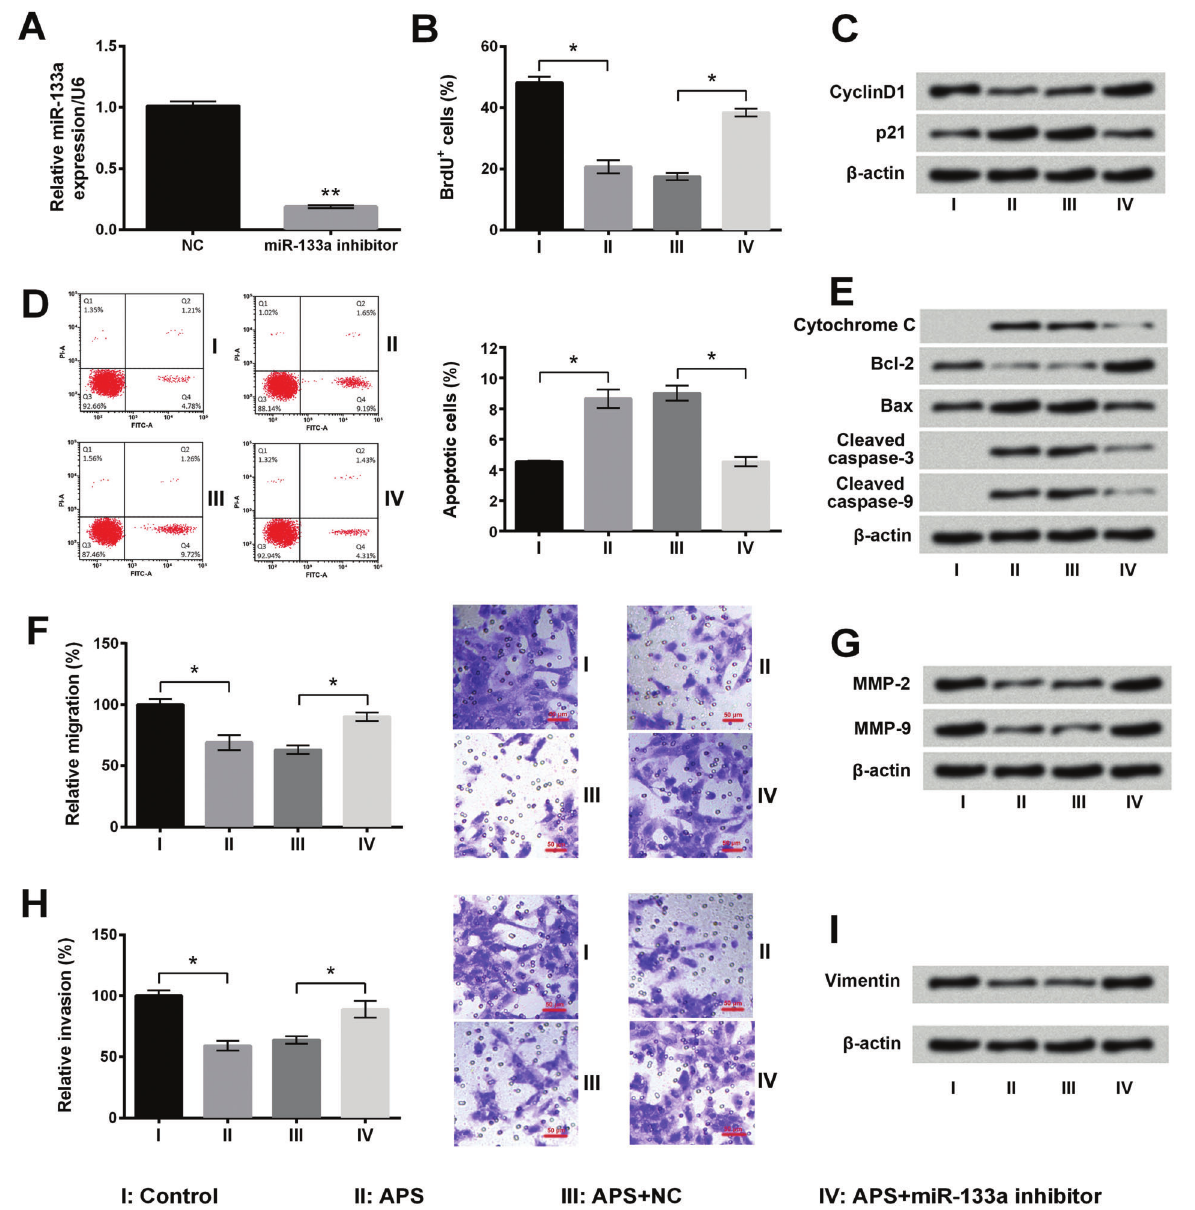
Figure 4. Effects of Astragalus polysaccharides (APS) on MG63 cells were reversed by miR-133a inhibition. A , After miR-133a inhibitor transfection, the expression of miR-133a in MG63 cells was determined by quantitative reverse transcription PCR. Transfected and non- transfected cells were stimulated with 10 mg/mL APS. Non-treated cells acted as control (NC). B , Percentage of BrdU positive cells was detected by BrdU incorporation assay. C , Expression levels of proliferation-associated proteins were assessed by western blot analysis. D , Percentage of apoptotic cells was measured by fl ow cytometry. E , Expression levels of apoptosis-associated proteins were evaluated by western blot analysis. F , Cell migration was determined by transwell migration assay. G , Expression levels of migration-associated proteins were detected by western blot analysis. MMP: matrix metalloproteinase. H , Cell invasion was measured by transwell invasion assay. I , Expression of invasion-associated protein was evaluated by western blot analysis. Data are reported as means ± SE of three independent experiments. *P o 0.05; **P o 0.01